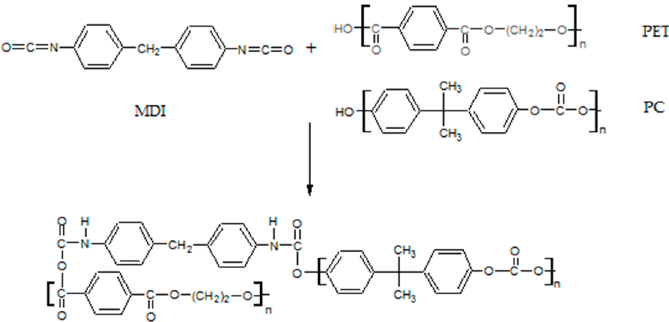
Figure 4. Possible reactions involved during the extrusion of the POST-I blend with MDI.